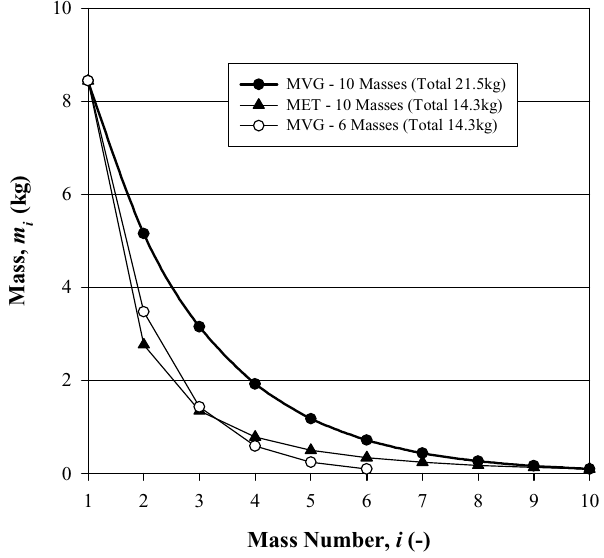
Fig. 17. Mass distributions for a system of 10 vertically-stacked masses comparing MVG and MET mass ratios (with e = 0 . 8 ), and also showing the masses for the optimised MVG system of 6 masses. (-) means non-dimensional.